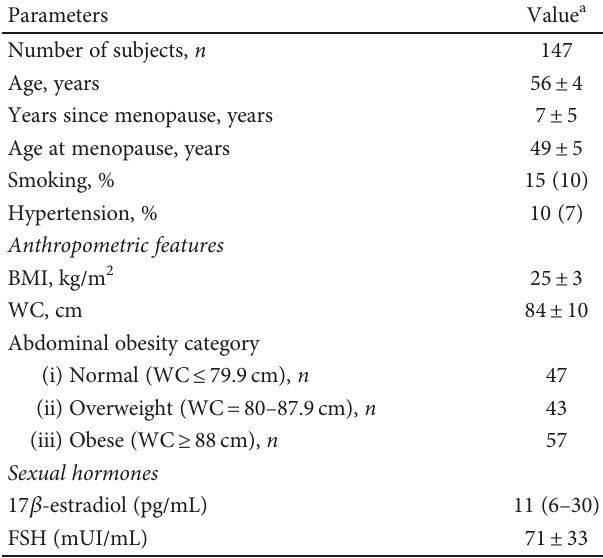
a Data are expressed as % within the group for categorical variables and number of subjects in brackets; mean ± standard deviation for continuous variables. BMI: body mass index; WC: waist